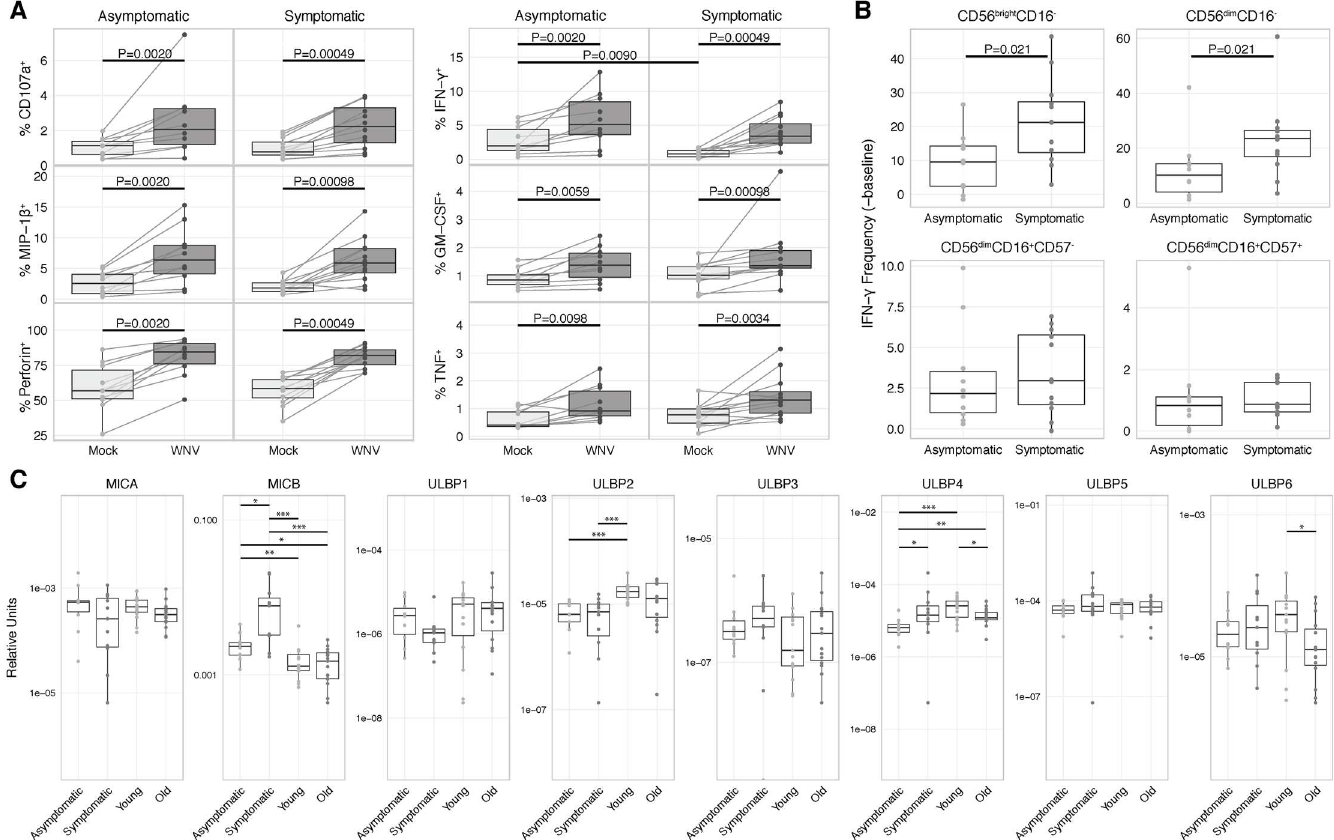
Fig 5. Robust functional response to WNV by NK cells from asymptomatic and symptomatic WNV subjects. PBMCs from asymptomatic (n = 10) and symptomatic (n = 12) WNV subjects were incubatedwith medium alone (mock) or infected with WNV (MOI = 1) for 24 h. (A) Total NK cells from mock and WNV-infected samples of each WNV subject were comparedby mass cytometry for surface expressionof CD107aand production of MIP-1 β , perforin, IFN- γ , TNF, and GM-CSF. Mock-WNV comparisons, pairedWilcoxon tests. Mock-mock and WNV-WNV comparisons, Mann-Whitney U tests. (B) Four NK cell subsets from asymptomatic and symptomatic WNV subjects were comparedfor inductionof IFN- γ by subtractingbaselineof the mock group from the WNV-infected group. Mann-Whitney U tests. (C) Samples from all four groupsof subjects (n = 56) were comparedby qPCR for baselineexpression of MICA, MICB, ULBP1, ULBP2, ULBP3, ULBP4, ULBP5, and ULBP6. Mann-Whitney U tests. P < 0.05 = * ; P < 0.01 = ** ; P < 0.001 = ***